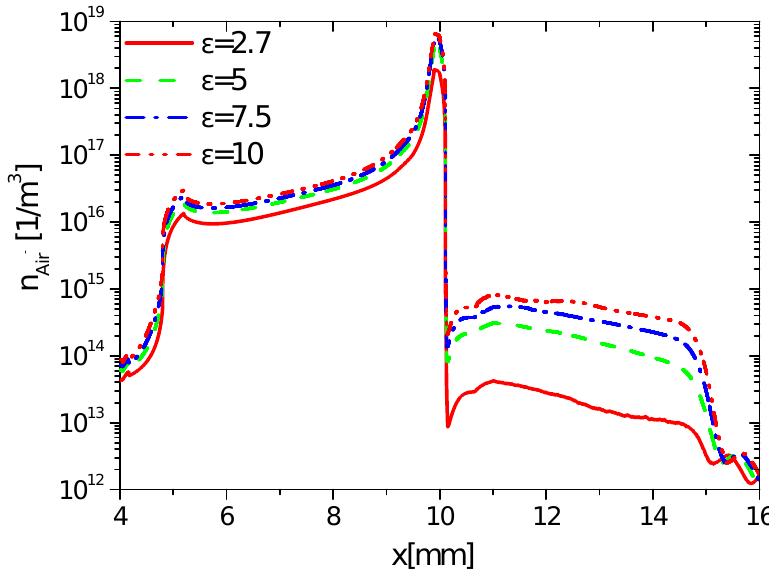
Figure 8. Effect of ε on the distributions of n e at 15 ns in the rise phase.